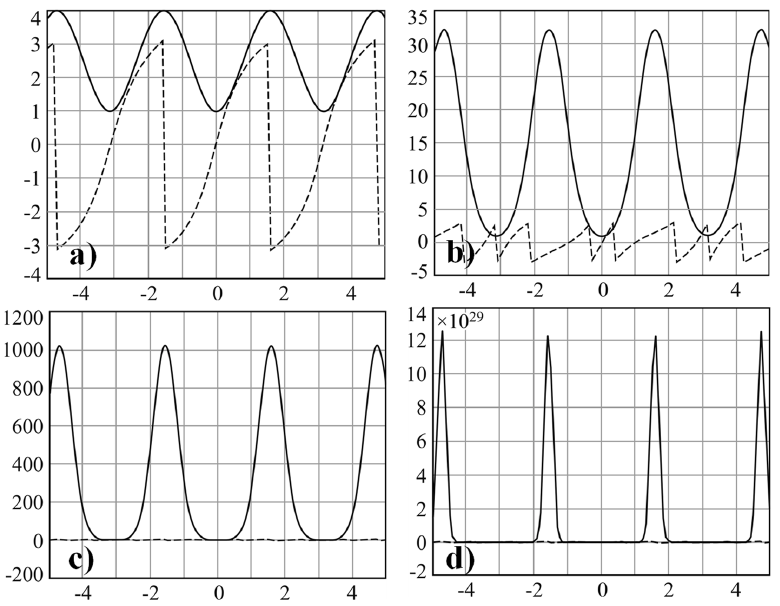
Figure 6. Complex field distribution of Equation (6) for a = 2 at different values of the power degree: ( a ) N = 2, ( b ) N = 5, ( c ) N = 10, ( d ) N = 100 (the amplitude is shown by the solid line, and the phase by the dashed line).